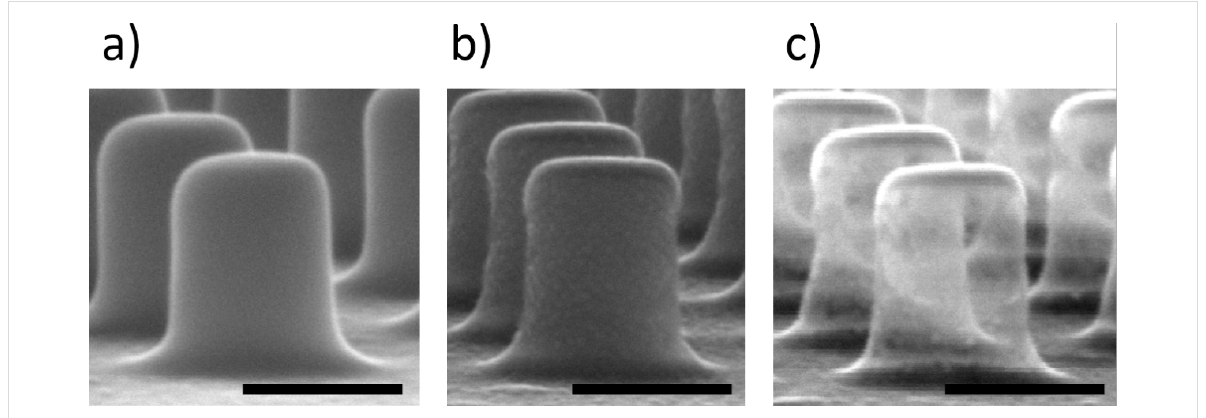
Figure 1: SEM images of the fabrication sequence of an array of hollow, closed, Al nanocages. a) SU-8 resist nanopillar array (period = 600 nm) fabricated by electron-beam lithography on an Al-coated Si substrate. b) Structure shown in (a) after the deposition of a thin Al film (thickness on hori- zontal surface = 40 nm) by metal evaporation. c) Structure shown in (b) after an oxygen-plasma treatment. The sidewalls appear transparent to the electron beam. The black scale bar in all images is 300